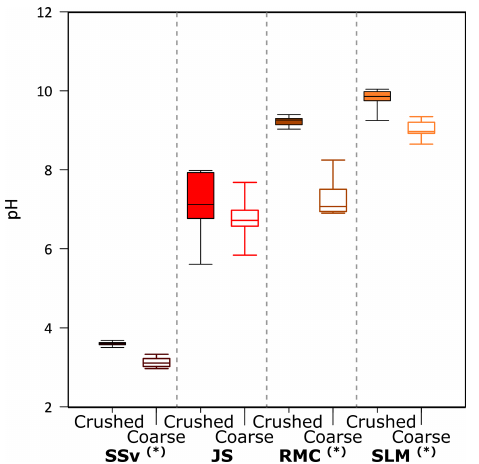
Figure 5. The pH of solutions at all time points (5min, 5h and 25h) of the incubation of crushed and coarse rock and sediment samples with ultra-pure water ( n = 9 for each sample and treatment). Highly significant difference ( p ≤ 0.01) between crushed and coarse sam- ples is denoted by ( ∗ ). The minimum and maximum values are rep- resented by the whiskers, the interquartile range is represented by the box, and the median value is shown by the line in the centre of the box.